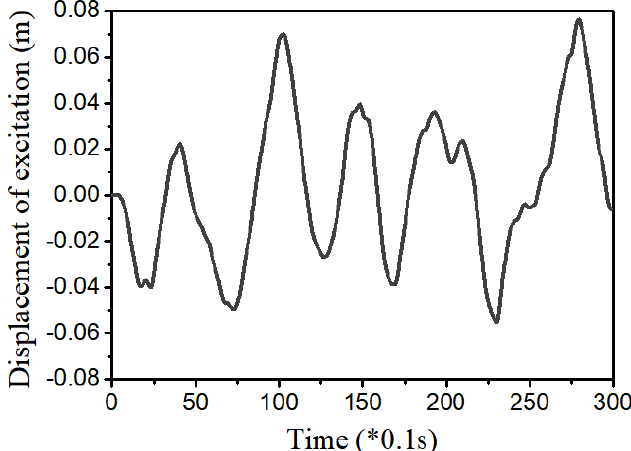
Figure 7. Random bump road excitation.